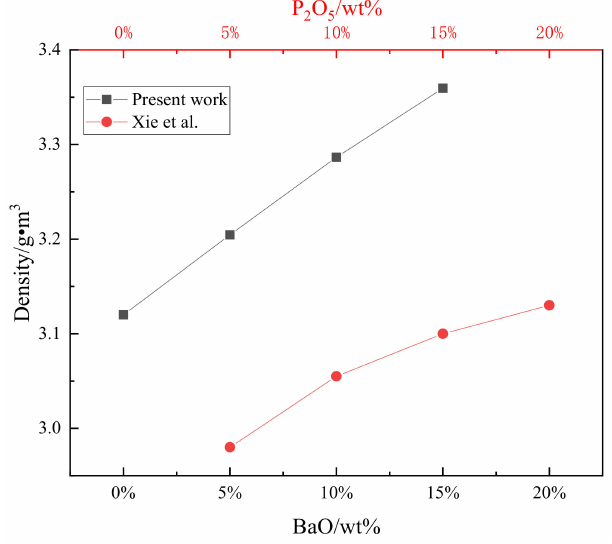
Figure 12. True density of the C 2 S–C 3 P solid solutions with various BaO contents.